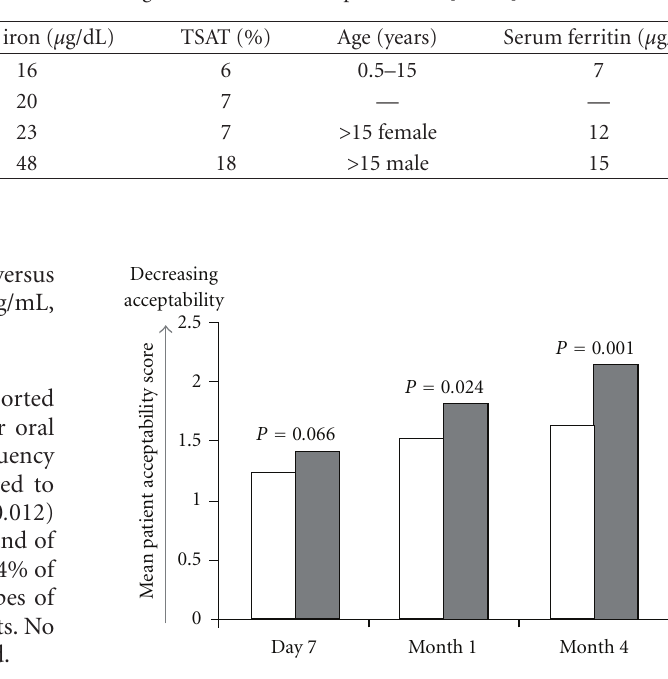
Table 1: Age-dependent lower limits of normal for hemoglobin and iron status parameters [10, 36].